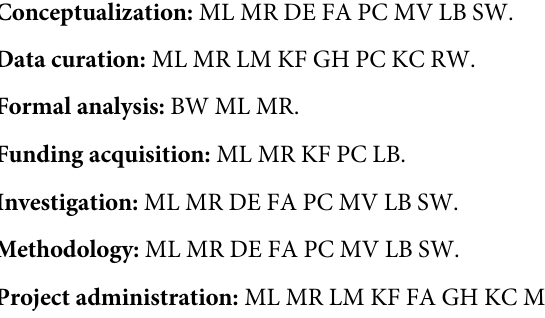
S1 Fig. CONSORT Flow Diagram. S1 Table. Direct Vaccine Protective